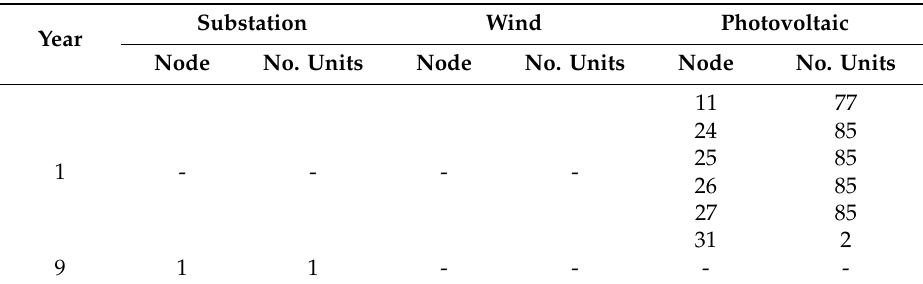
Table 6. Nodal allocation of new power installed for Case a.